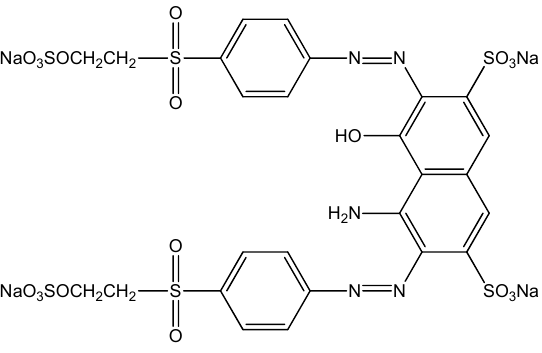
Figure 1. Molecular structure of Reactive Black-5.